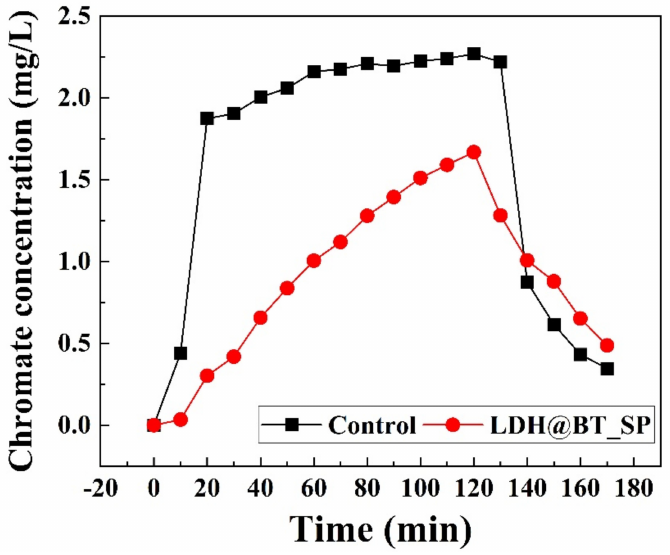
Figure 8. The time variation in chromate concentration in a silica-sand-filled box in the absence and presence of the LDH–BT_SP (adsorbent concentration = 10 g/L; flow rate = 9.0